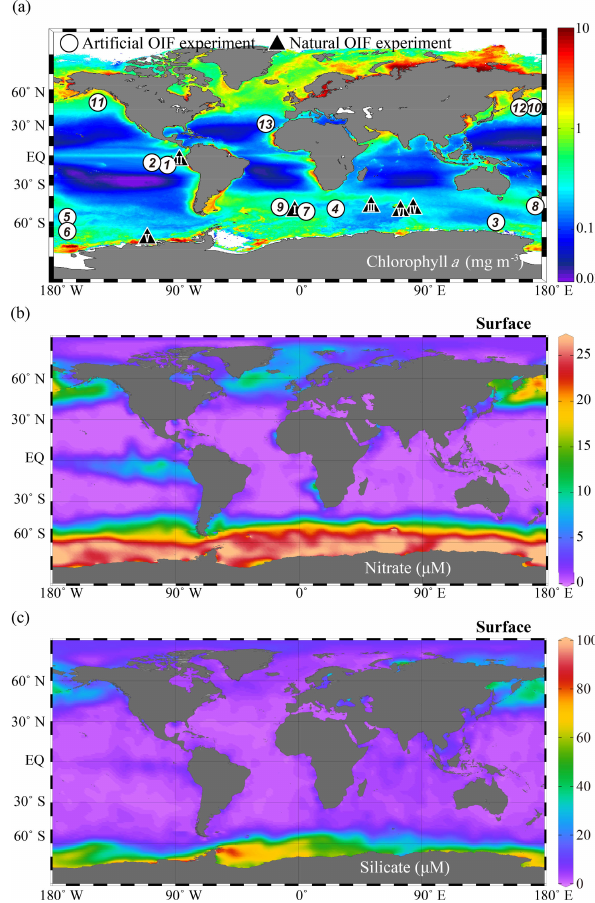
Figure 4. Global annual distribution of surface (a) chlorophyll con- centrations (mgm − 3 ), (b) nitrate concentrations (µM), and (c) sil- icate concentrations (µM). The chlorophyll a concentration distri- bution was obtained from the Aqua MODIS chlorophyll a com- posite from July 2002 to February 2016 (https://oceancolor.gsfc. nasa.gov/cgi/l3, last access: 6 September 2018); nitrate and sili- cate were obtained from the World Ocean Atlas 2013 dataset (https: //odv.awi.de/en/data/ocean/world-ocean-atlas-2013, last access: 6 September 2018) and plotted using Ocean Data View (Schlitzer, 2017). The white circles indicate the locations of 13 artificial ocean iron fertilization (aOIF) experiments and the black triangles indicate the locations of six natural OIF (nOIF) experiments. Note that the numbers indicate the order of the aOIF experiments and the roman numerals indicate the order of the nOIF experiments (see Table